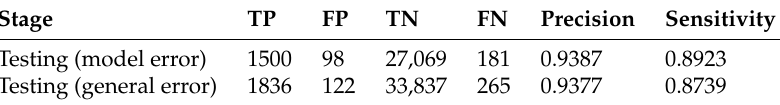
Table 4. Retraining Strategy II performance at learning rate